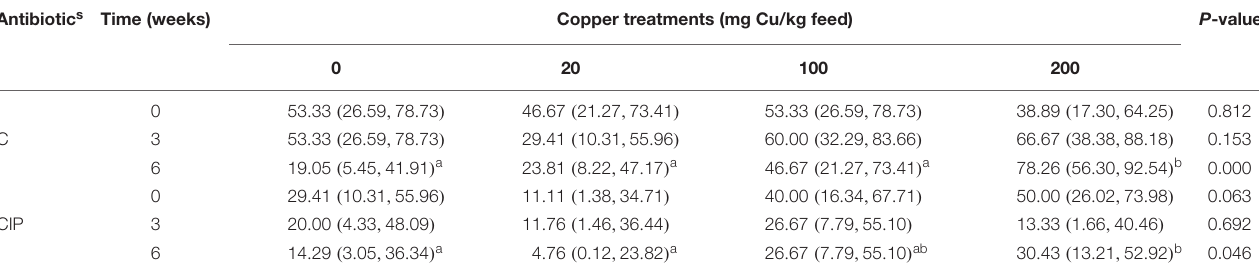
TABLE 5 | Antimicrobial resistance rates (95% CI) of Escherichia coli from anal swabs 1 . Antibiotic s Time (weeks) Copper treatments (mg Cu/kg